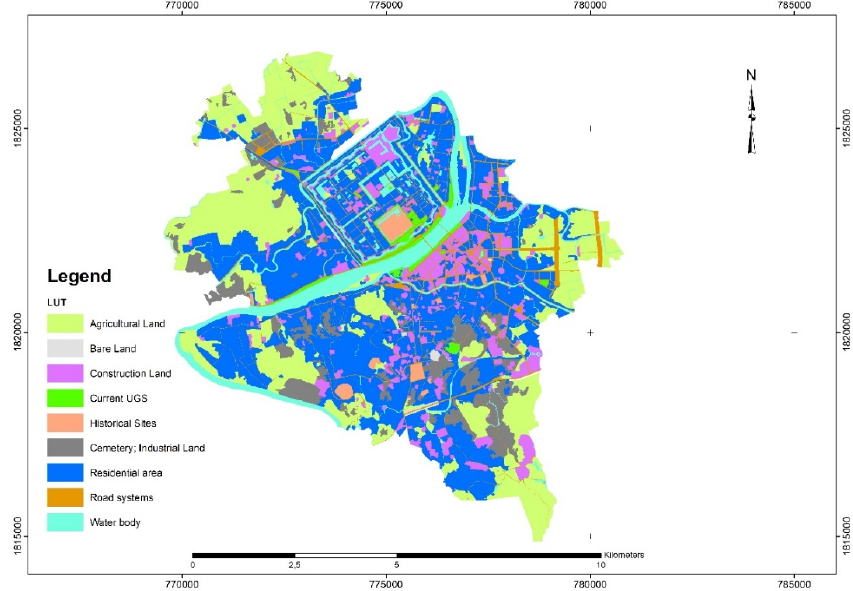
Figure 7. Map of the current land use types ( source: Land Use Map in 2020 of Hue City ).